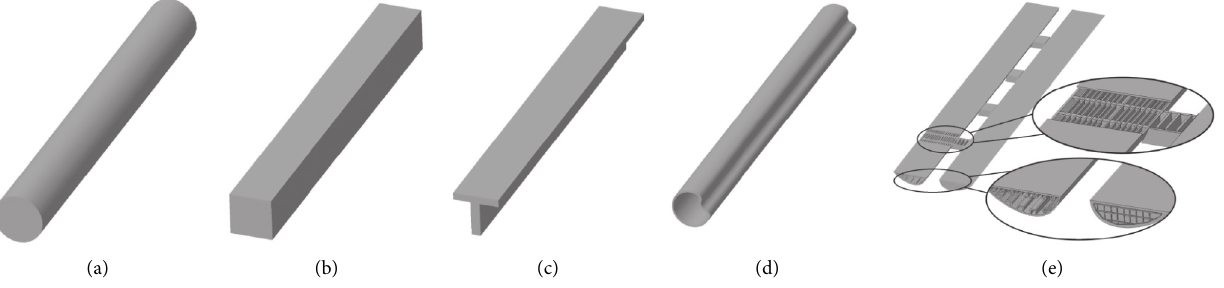
Figure 1: Straight beam with different cross-section